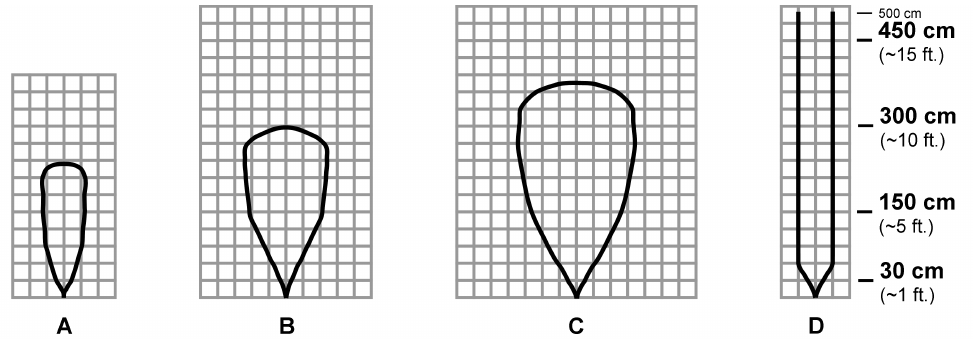
Figure 2. Two-dimensional beam pattern representation of the MaxBotix MB1403 ultrasonic